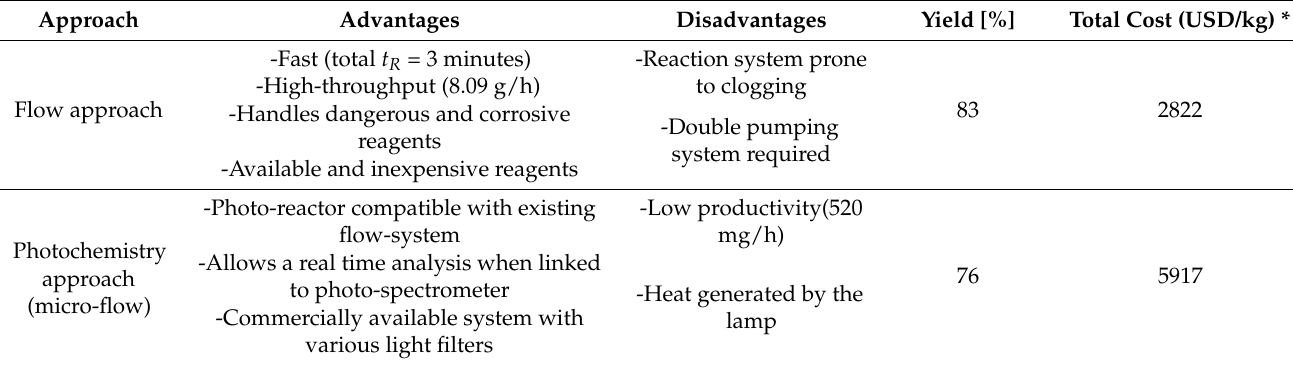
Table 3. Comparison of flow and photochemical approaches to ibuprofen